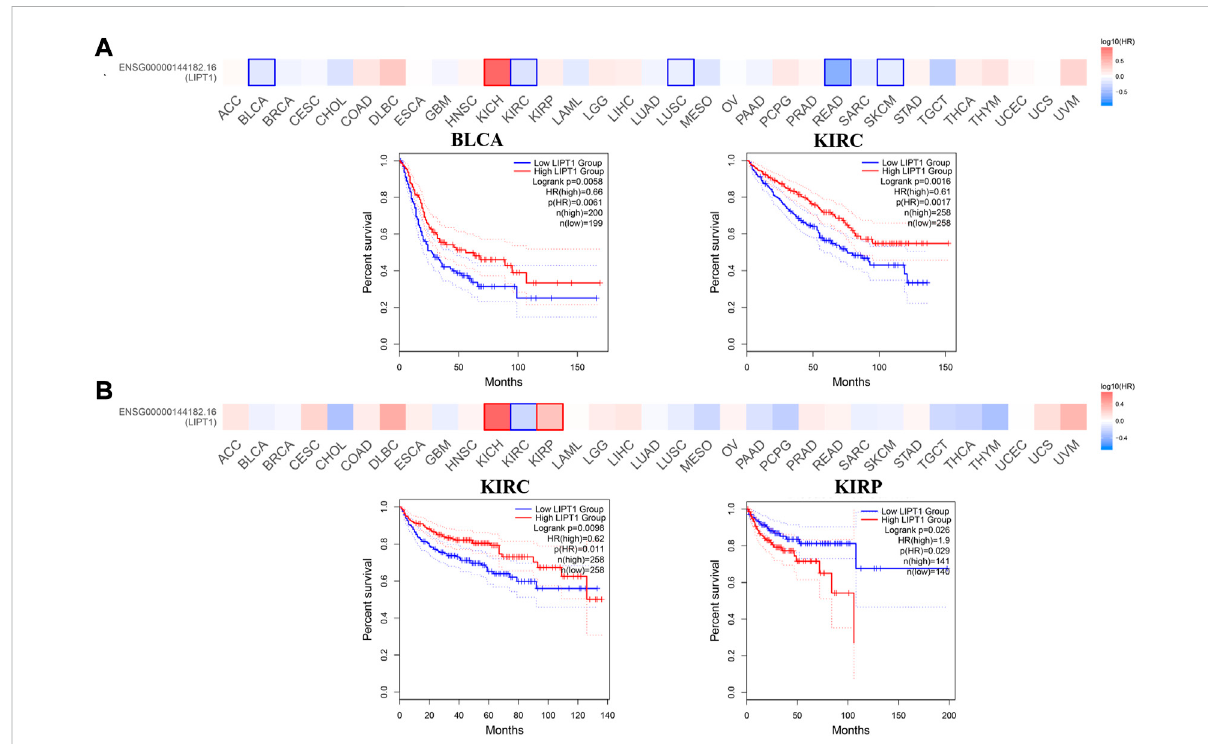
FIGURE 3 Prognostic values of LIPT1 expression in pan-cancer. (A,B) GEPIA2.0 was used to analyze the effects of LIPT1 gene expression on the patients ’ prognosis in pan-cancer, including OS (A) and DFS (B)